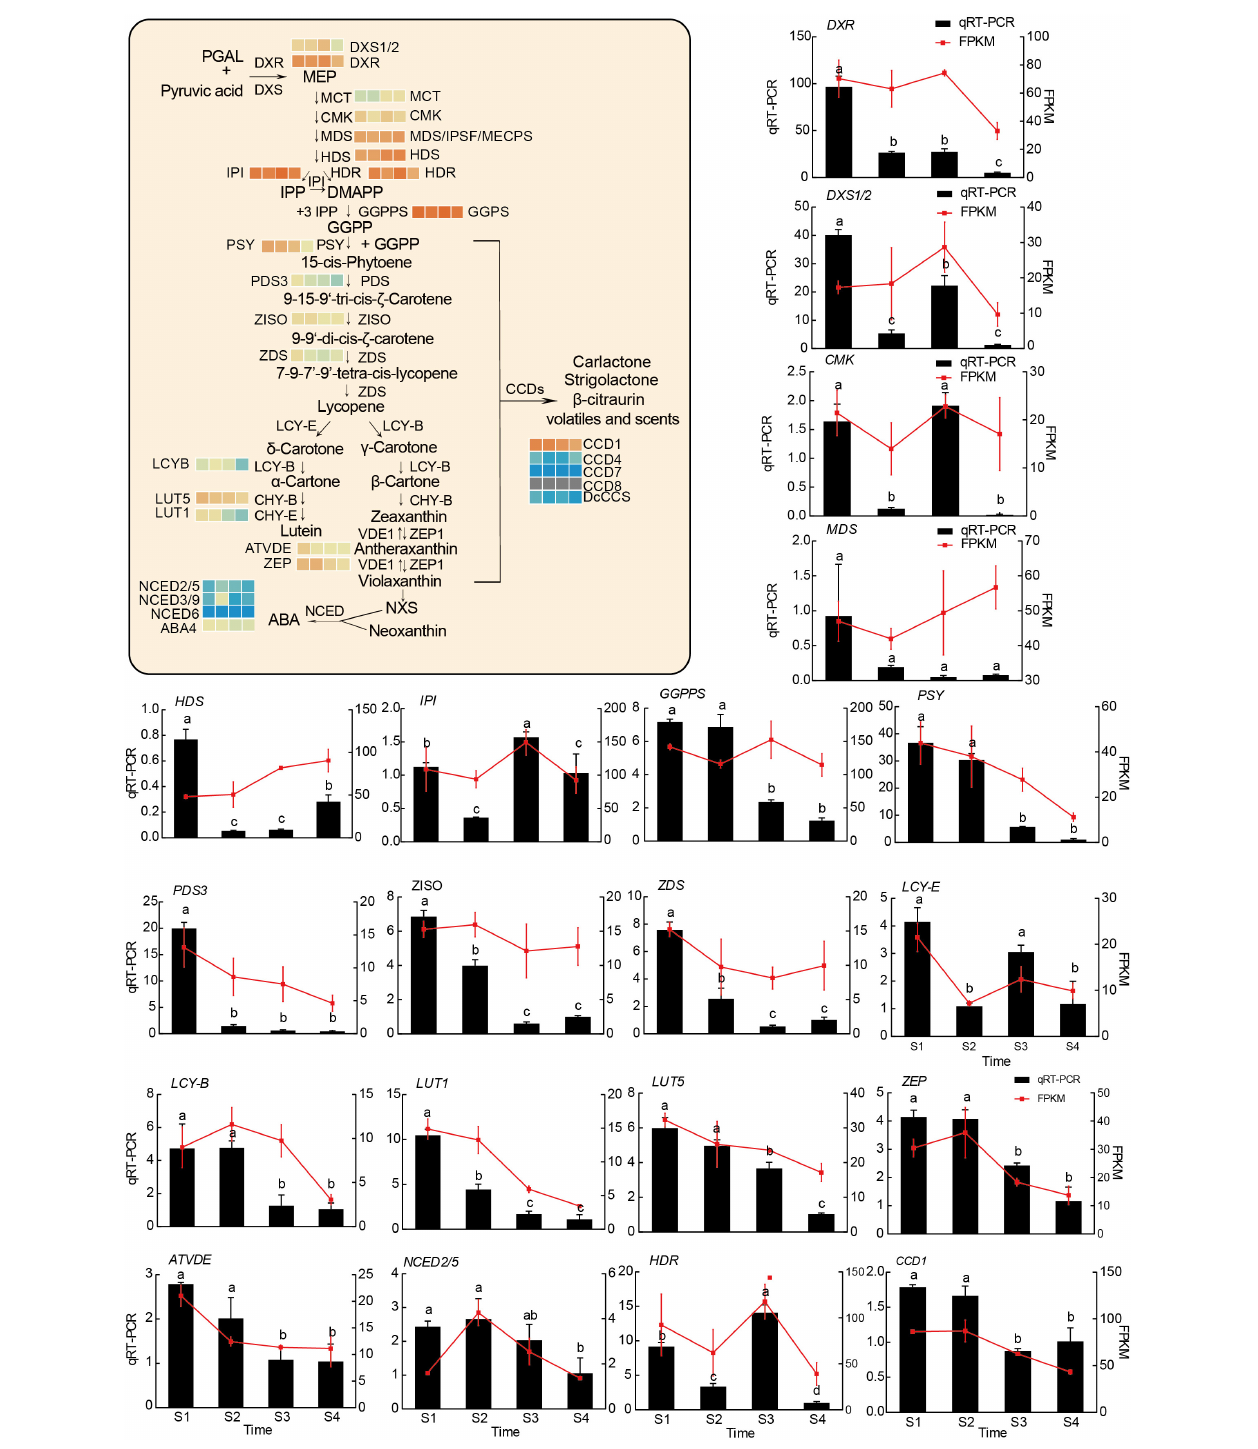
FIGURE 6 | The model diagram of the main carotenoid metabolism pathway, and transcriptional analysis of and qRT-PCR assays of 20 genes associated with carotenoid metabolism. R-package heatmaps were applied to map the expression heatmap of these genes. The heatmap data were homogenized by log2 (FPKM). The relative expression levels of target genes were calculated by the 2 − (cid:49)(cid:49) Ct method against the internal control ( CcUBC9-5 ). Experiments were conducted with three independent biological replicates and three technical replicates. Different letters indicated significant differences ( P < 0.05, Tukey’s HSD) by ANOVA among